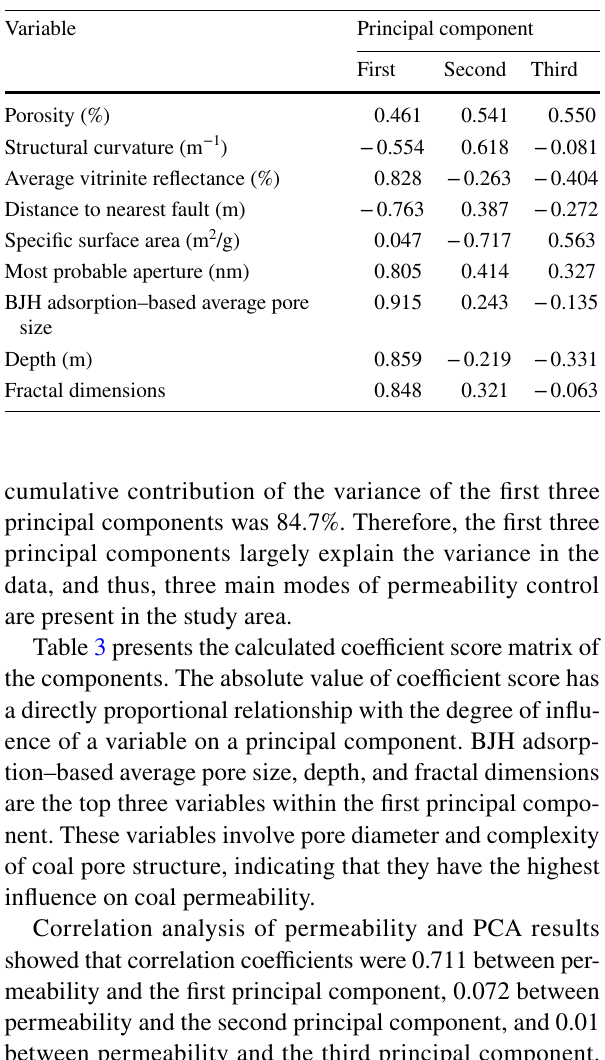
Table 3 Scores of the first, second, and third principal components for different